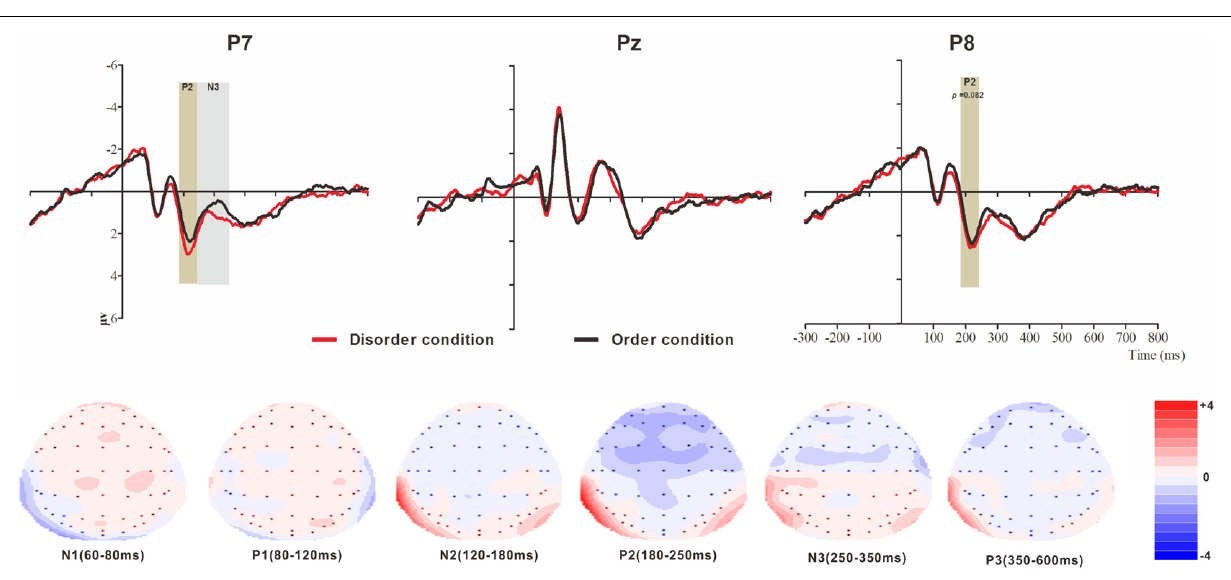
( − 1.13) than in the left ( − 0.44 µ V) and right ( − 0.83 µ V) hemispheres. No interaction effect was found ( F (2, 46) = 0.036, p > 0.05). Nonetheless, the planned contrasts of order type